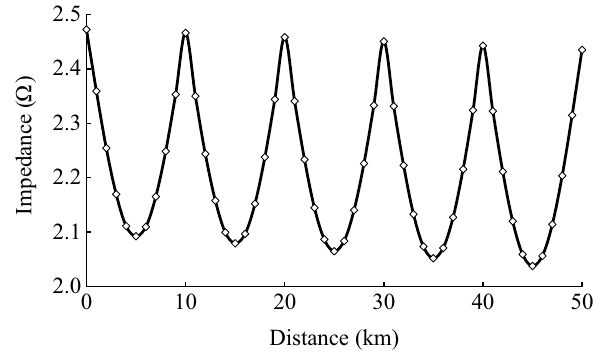
Fig. 14 Equivalent impedance of locomotive